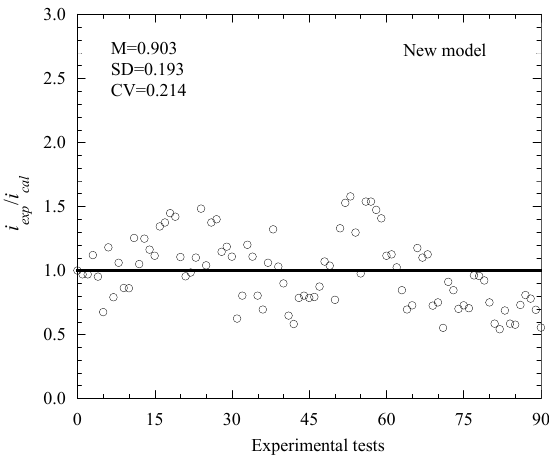
Figure 4. Comparison and analysis of the experimental value and the predicted value of the new model.